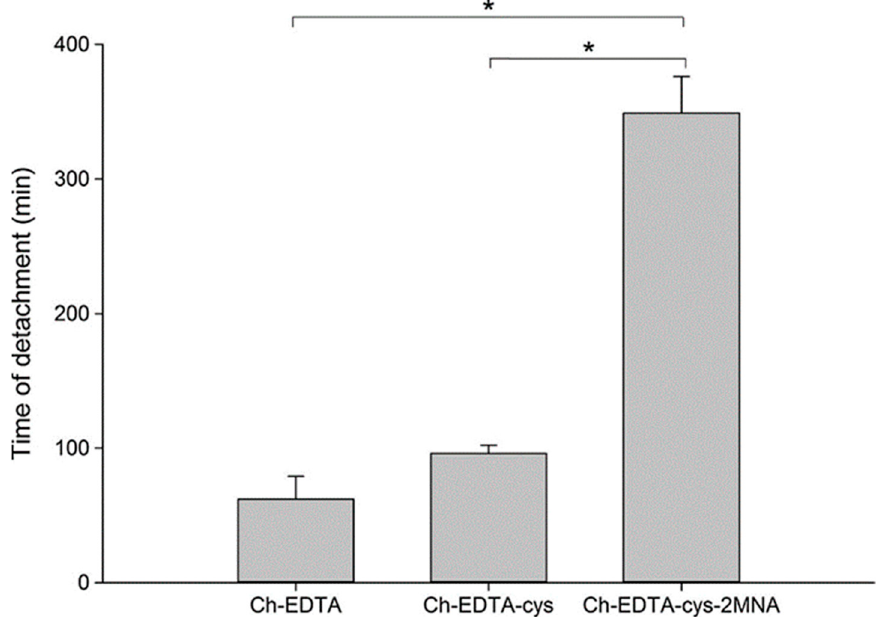
Figure 18. Mucoadhesion time of mini-tablets containing 30 mg of Ch-EDTA, Ch-EDTA-cys or Ch-EDTA-cys-2MNA studied by rotating cylinder method using porcine intestinal mucosa. Ch: chitosan, cys: cysteine, 2MNA: 2-mercaptonicotinamide. (Mean ± SD, n = 5, * denotes statistical significant difference at p < 0.05). Reprinted from [138] with permission of